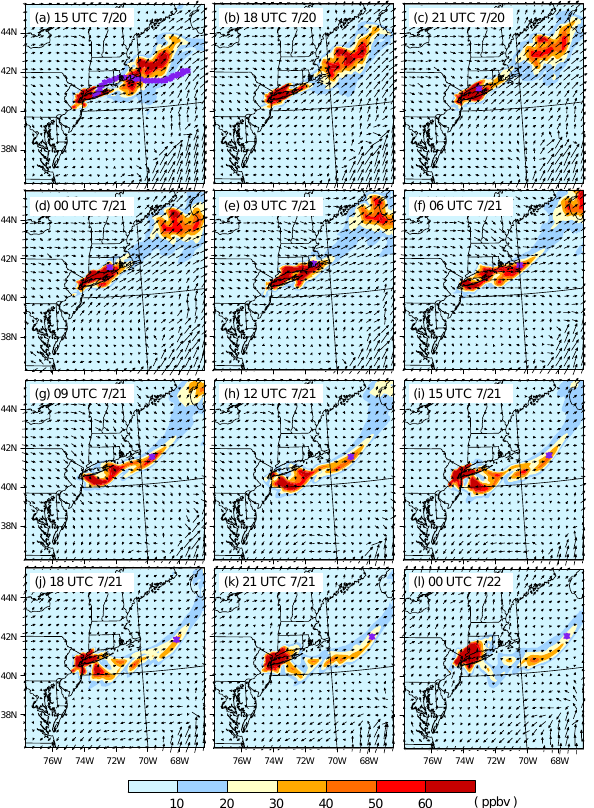
Fig. 11. Horizontal distributions of simulated CO NYC mixing ratios and horizontal wind fields in the upper-level NYC plume layer from 15:00 UTC on 20 July to 00:00 UTC on 22 July with 3-h intervals. The plotted CO NYC mixing ratios are the difference between sim- ulation with doubled CO emissions of the New York City area and control simulation, and vertically averaged from ∼ 600m to ∼ 1300 m. The full forward trajectory of an urban CO plume originated from New York City from 18:00 UTC on 20 July to 00:00 UTC on 22 July is shown in (a) , and the location of the plume tracked is depicted by asterisk marks in (c–l)